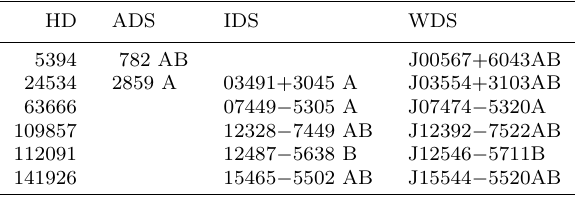
Table 2. X-ray binaries, members of multiple